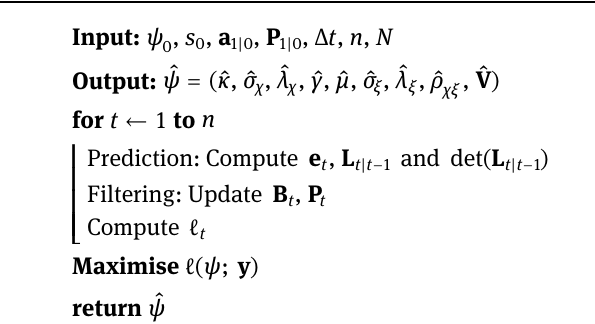
Algorithm 1 : Kalman fi lter and estimation of